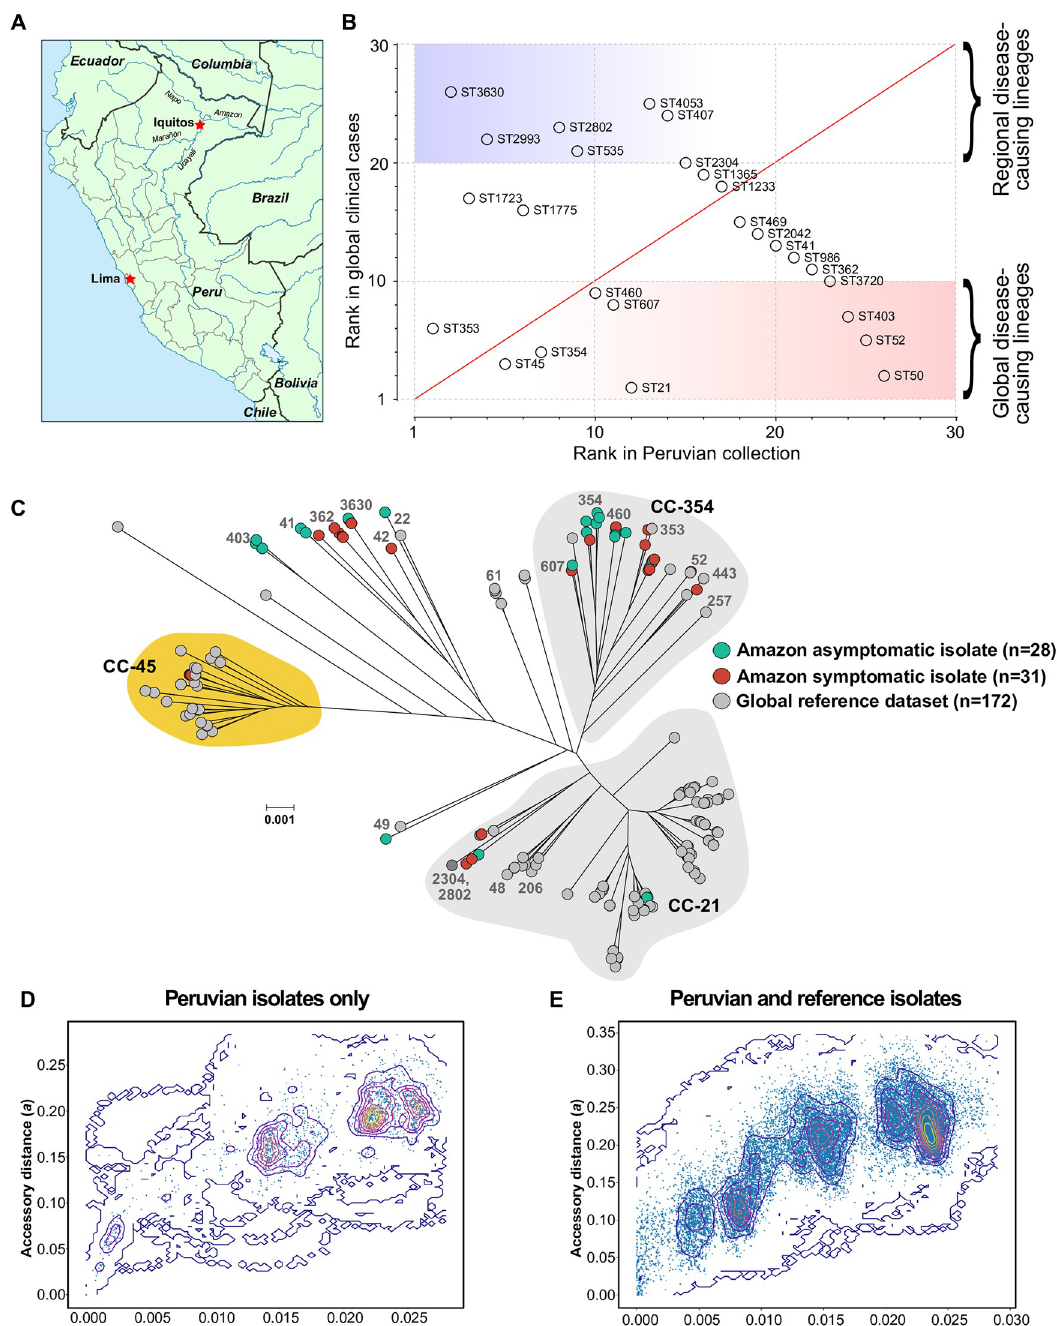
Fig 1. ( A ) Location of study site in Santa Clara, near Iquitos in Peru. ( B ) Sequence types (STs) of isolates collected from children in the Peruvian Amazon ranked according to the frequency in our local dataset and how often they have been sampled from human disease isolates (data from pubMLST; https://pubmlst.org/). ( C ) Population structure of C . jejuni isolates used in this study. All core (present in � 95% of isolates) genes from the reference pan-genome list (2,348 genes) were used to build alignments of the Peruvian isolates (n = 62) contextualized with 164 previously published genomes representing the known genetic diversity in C . jejuni (n = 234, alignment: 720,853 bp. A maximum-likelihood phylogeny was constructed with IQ-TREE, using a GTR model and ultrafast bootstrapping (1,000 bootstraps; version 1.6.8) [55,56].Scale bar represents genetic distance of 0.001. Leaves from asymptomatic Peruvian isolates are colored green; symptomatic Peruvian isolates are red; and isolates from the reference dataset are grey. Common STs and clonal complexes (CC), based on four or more shared alleles in seven MLST housekeeping genes, are annotated [60]. Interactive visualization is available on Microreact [57]: https://microreact.org/project/CampyPeruContext. ( D